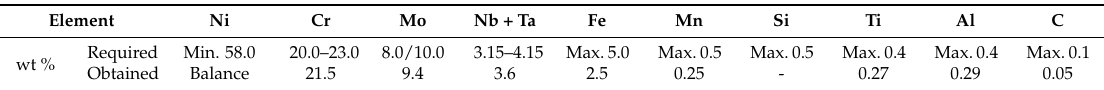
Table 1. The chemical composition required by the ASTM standard and obtained by the ICP-OES for the Inconel 625 alloy.